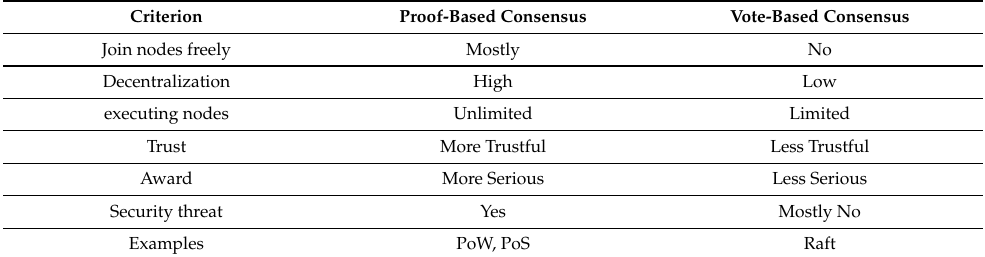
Table 3. Difference between proof-based and vote-based consensus algorithms [31].